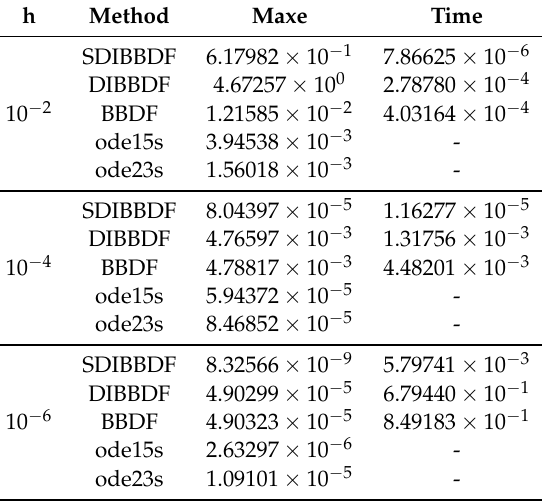
Table 4. Numerical results for test problem